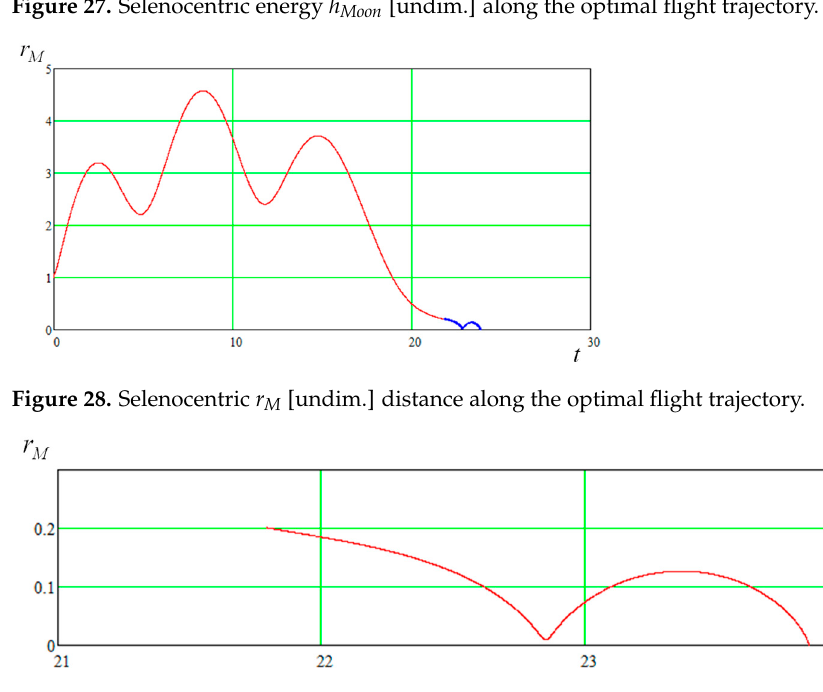
Figure 29. Relative selenocentric distance r M [undim.] of the SC during its trajectory motion in the “near-moon” section up to a circular orbit of a given radius.